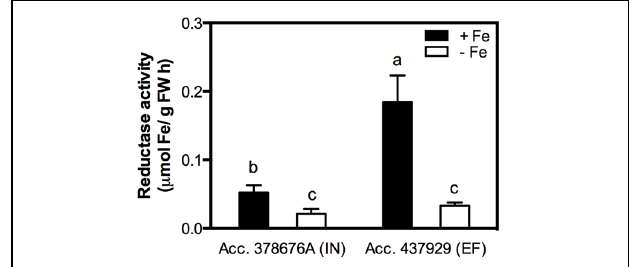
Fe-deficient ( − Fe) hydroponic conditions. Data are mean ± SE of five biological replicates. Different letters indicate significant differences ( P < 0.05).